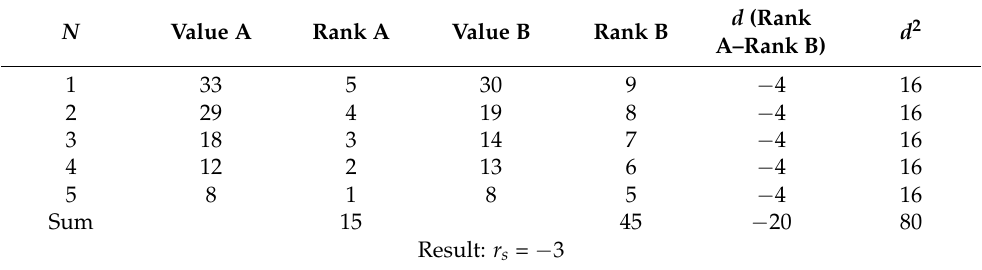
Table 3. Determination of Spearman’s rank linear correlation indicator based on the ratio of the degree of satisfaction with the use of ICT and the assessment of the use of the main ICT tools in the activities of industrial enterprises of the Republic of Mordovia. N Value